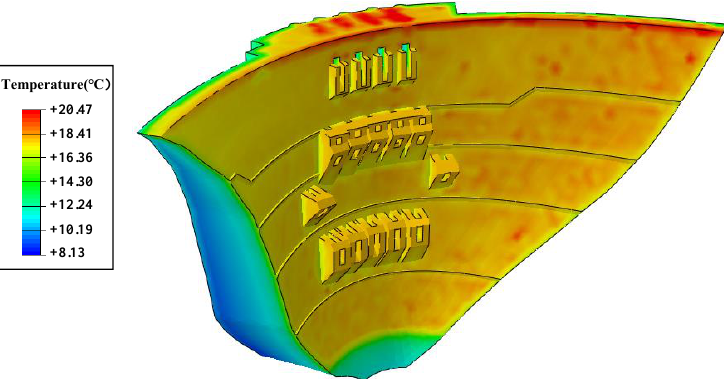
Figure 9. The temperature fields of the arch crown beam on a summer solstice day. ( a ) Considera- tion of solar radiation. ( b ) Without consideration of solar radiation.